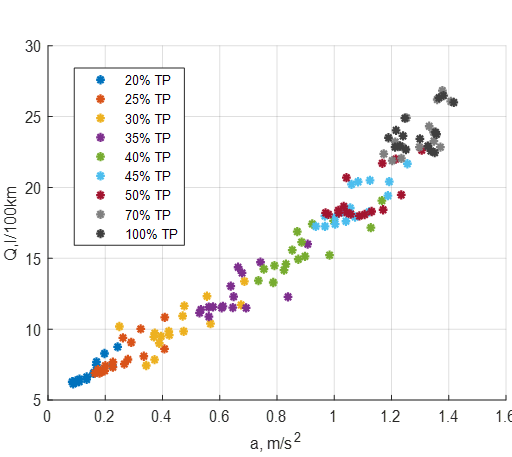
Fig. 4. Variations in distance-related fuel consumption in the acceleration elasticity test of a vehicle with constant transmission on dynamometer for constant throttle positions